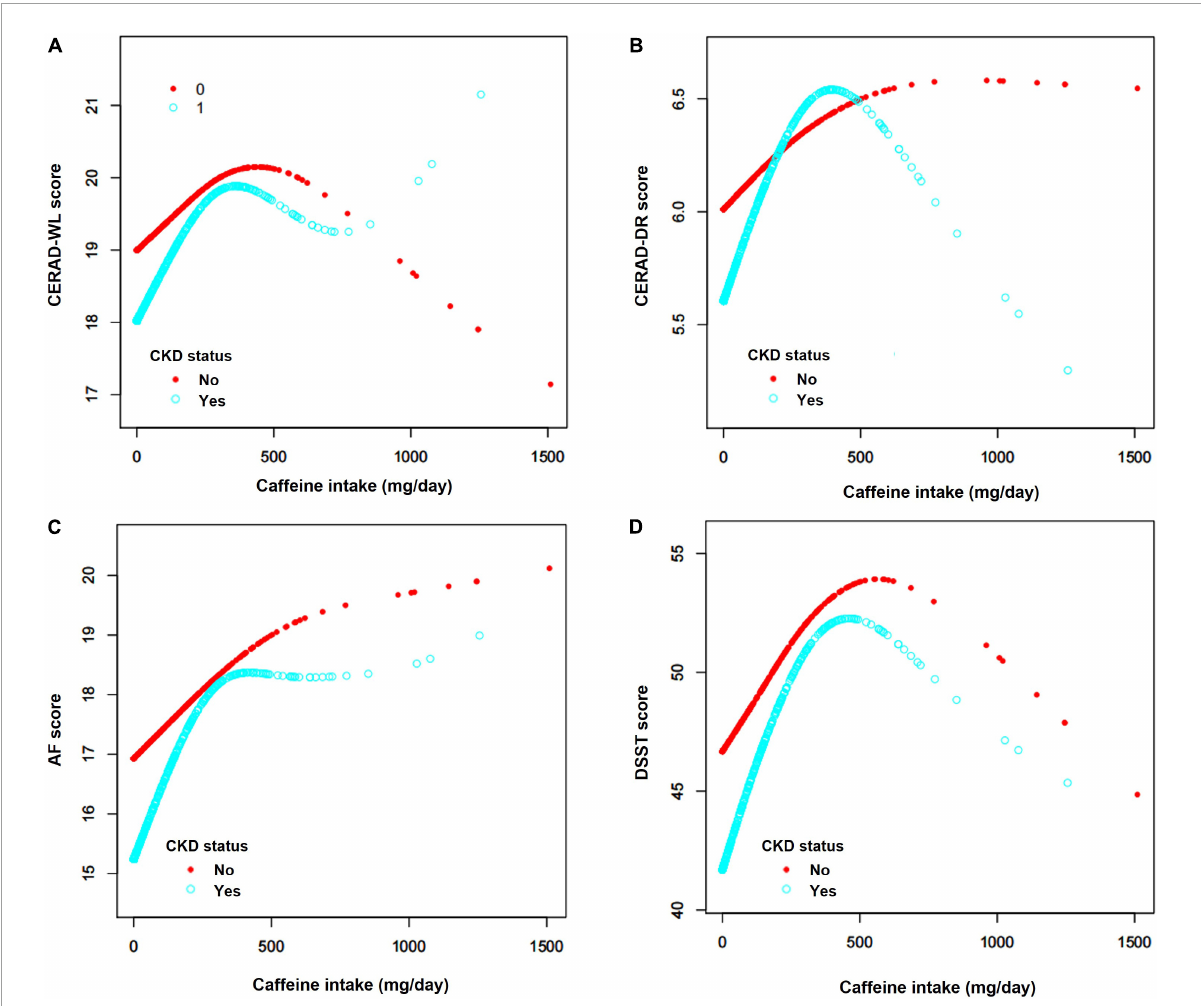
FIGURE7 (A–D) Associations between caffeine intake and cognitive tests. The analyses showed a non-linear relationship between caffeine intake and the four cognitive tests, including the Consortium to Establish a Registry for Alzheimer’s Disease Word Learning Test (CERAD-WL), the Consortium to Establish a Registry for Alzheimer’s Disease Word List Recall Test (CERAD-DR), the Animal Fluency test (AF) and the Digit Symbol Substitution test (DSST). The blue curves represent CKD patients, and the red curves represent non-CKD subjects. For all tests, both of CKD and non-CKD subjects, positive associations were found when caffeine intake was below or equal to the inflection point. Negative associations were only found for the AF and DSST scores of CKD patients when caffeine intake was above the inflection point. The inflection points of CKD patients were 288 mg/day for CERAD-WL, 306 mg/day for CERAD-DR, 279 mg/day for AF and 294 mg/day for